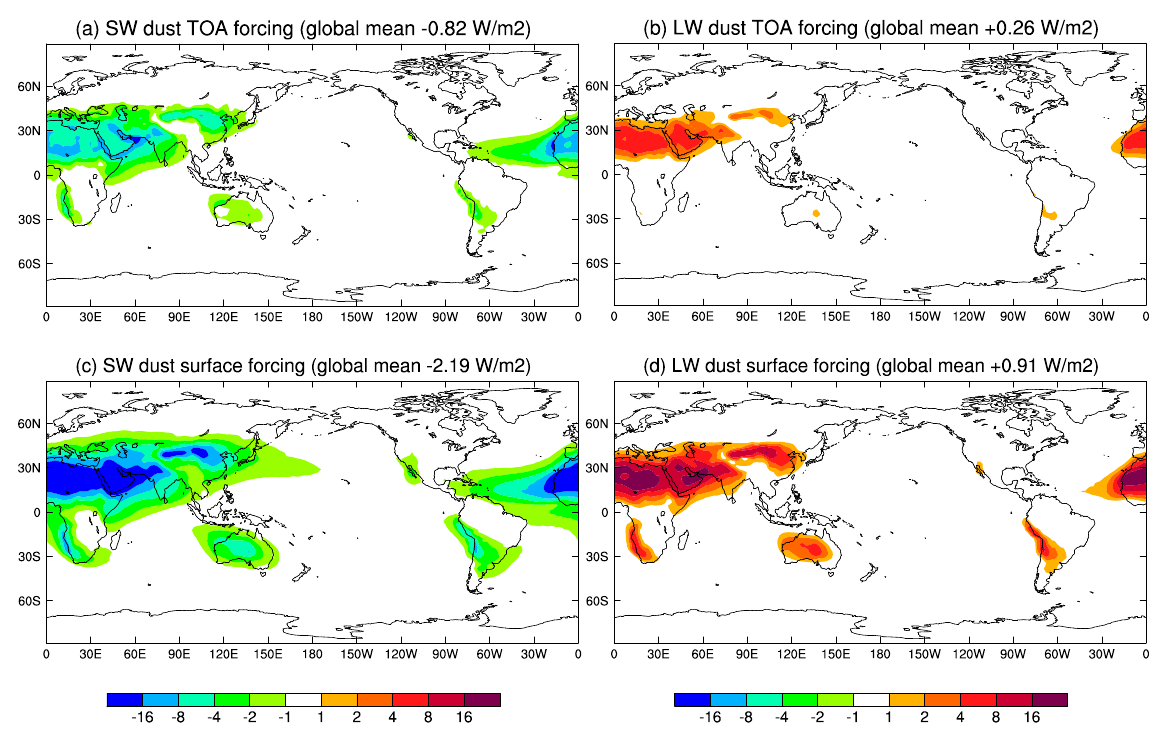
Fig. 1. Annual-mean simulated dust radiative forcing from the DUST run in W m − 2 (a) shortwave at the top of the atmosphere, (b) longwave at the top of the atmosphere, (c) shortwave at the surface, and (d) longwave at the surface.